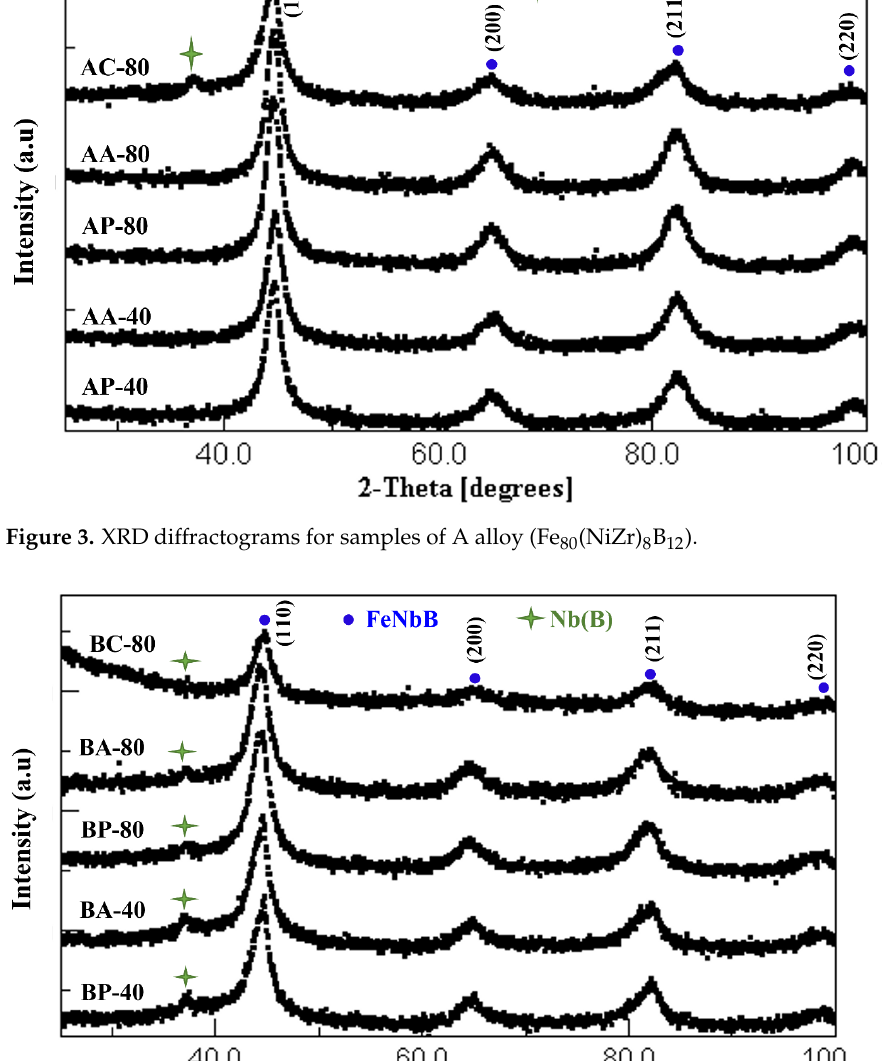
5 of 13 Figure 2. Particle size distribution of: ( a ) AP-40, ( b ) AA-40, ( c ) BP-40, and ( d ) BA-40. Regarding the composition checked by ICP, the results show the composition ratios of Fe, Ni, Zr, Nb, and B are similar in powders and agglomerates to the nominal compo- sition (and also in bulk specimens). Lastly, as seen in the SEM micrographs of the compacted samples, the BC-80 exhib- ited a higher tendency to compact than the AC-80, which showed visible holes and pores. 3.2. XRD Analysis